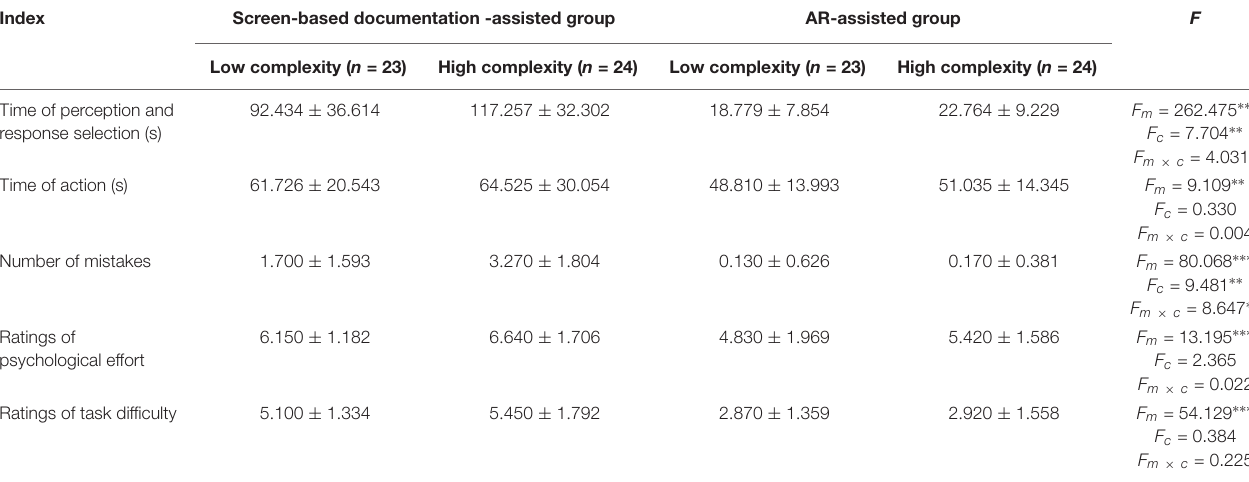
TABLE 2 | Performance data of the commissioning subtask with various complexities in different stages under two assistance modes.